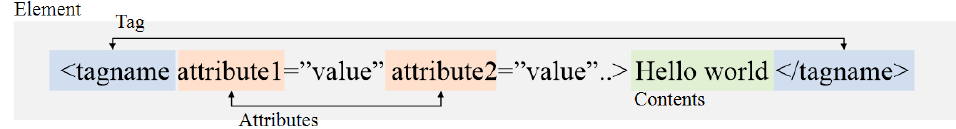
Figure 4. The basic structure of the Hyper Text Markup Language (HTML) webpage element (with a tag, attributes, and values).